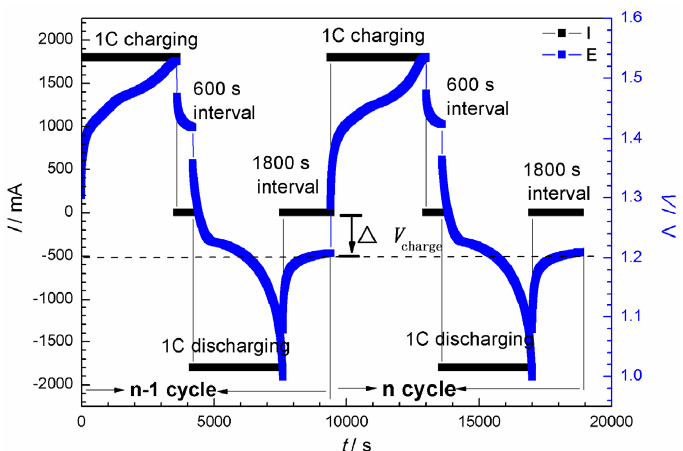
Figure 1. Typical I - t and V - t curves in the charge-discharge test at 1.0C for Ni-MH batteries (AA-type, 1.8 Ah, 1.2 V).